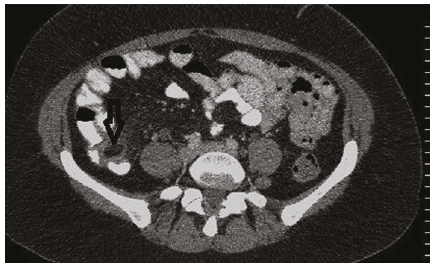
Figure 1: Axial CT abdomen with oral contrast showing caecal epiploic appendagitis with minor pericaecal fat stranding (vertical white arrow).